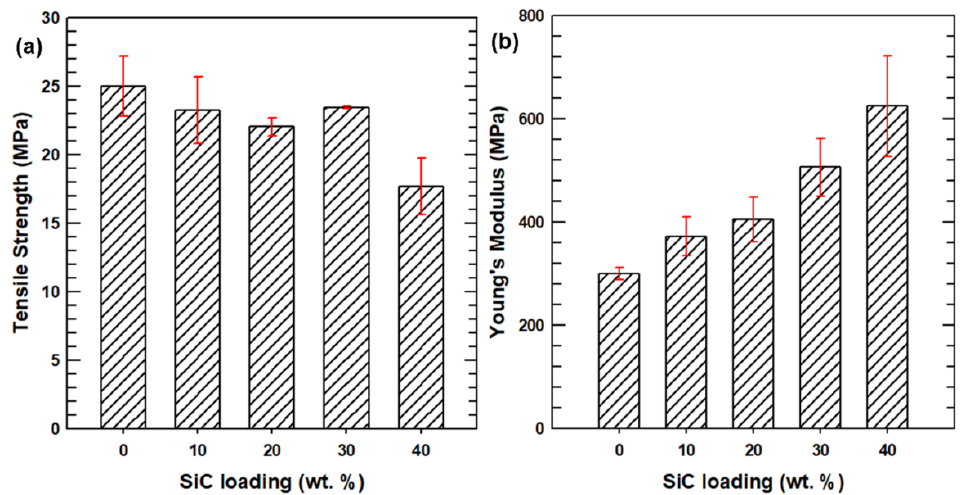
Figure 5. Tensile properties of the neat PBS and PBS composites: ( a ) tensile strength and ( b ) Young’s modulus.